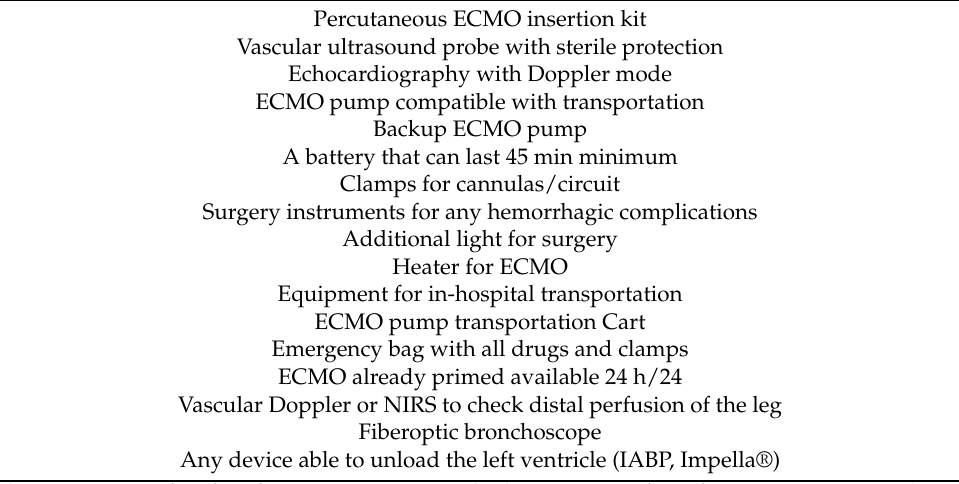
Table 1. Equipment and installation to implement ECPR (extracorporeal cardiopulmonary resuscitation). Percutaneous ECMO insertion